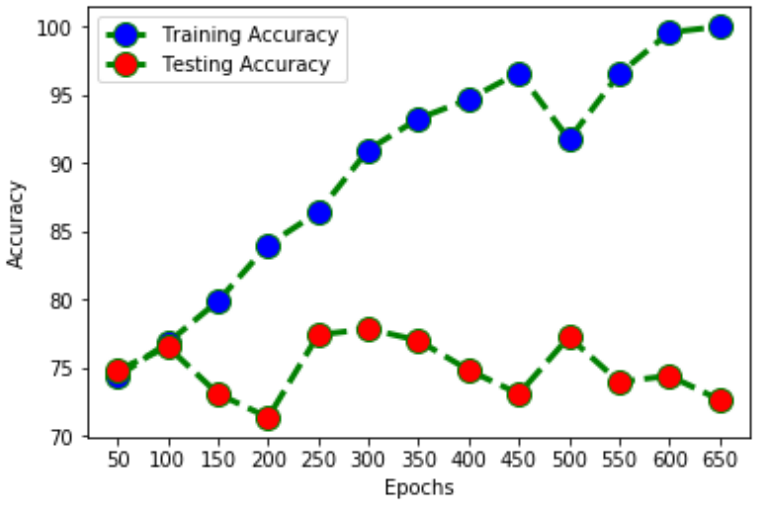
Figure 5. Performance Evaluation Based on Number of